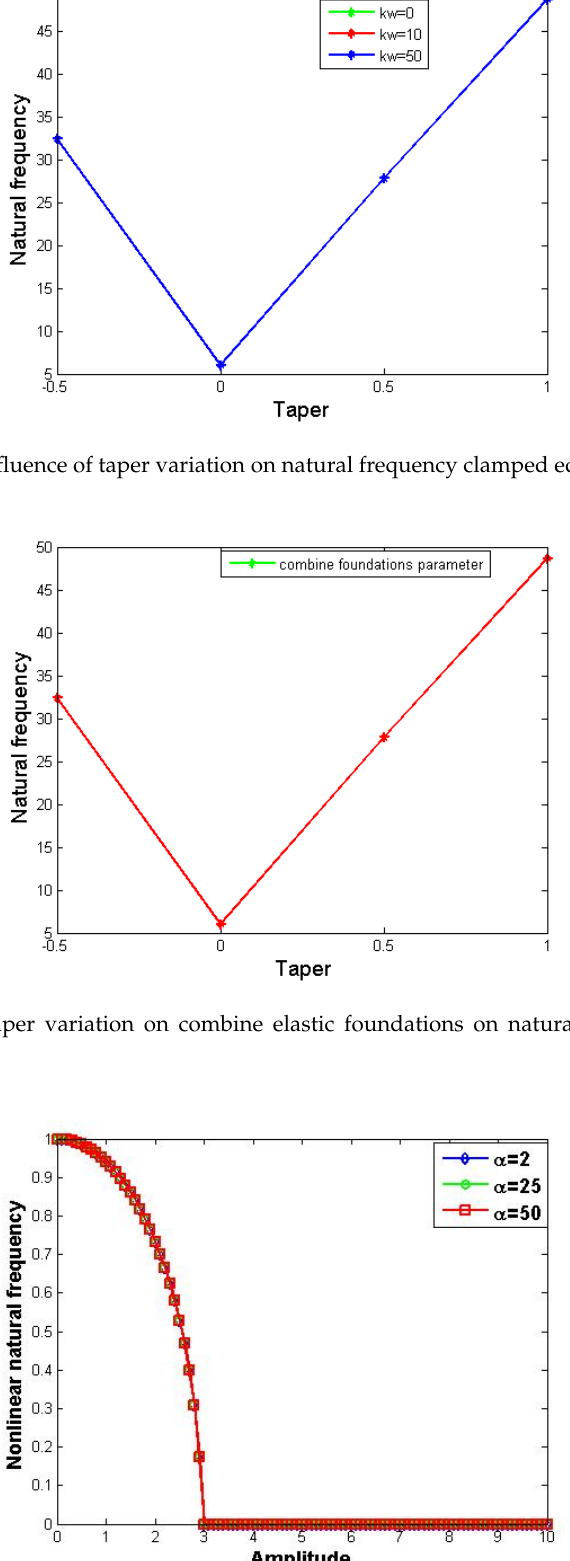
frequency. The effects of taper parameters variation on the nonlinear amplitude frequency curve response